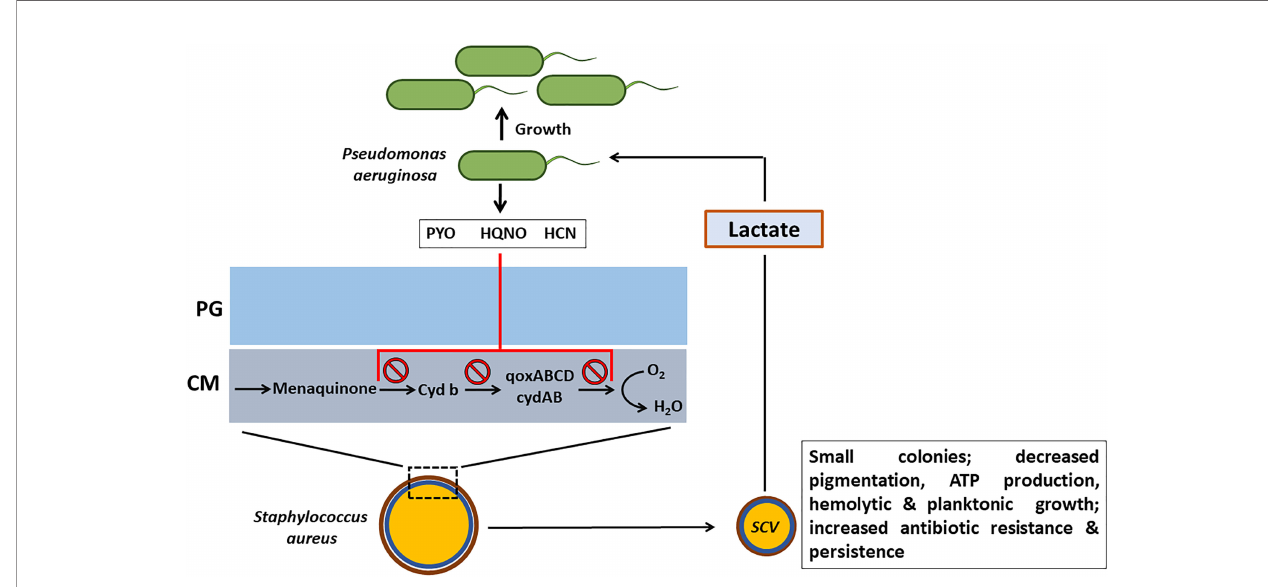
FIGURE 3 | Effect of respiratory inhibitors of P. aeruginosa on S. aureus. P. aeruginosa secretes small respiratory inhibitors such as pyocyanin (PYO), hydrogen cyanide (HCN) and quinoline N -oxides (HQNO) that target the electron transport pathway (ETC) and block the transport of electrons. S. aureus shifts to fermentative metabolism and adapts the small colony variant (SCV) phenotype to survive. In addition to resisting the respiratory inhibitors of P. aeruginosa , SCV phenotype imparts several advantages to S. aureus such as increased antibiotic resistance and persistence. The lactate that is produced by S. aureus SCVs will be consumed by P. aeruginosa as a preferential carbon source. PG, peptidoglycan; CM, cell